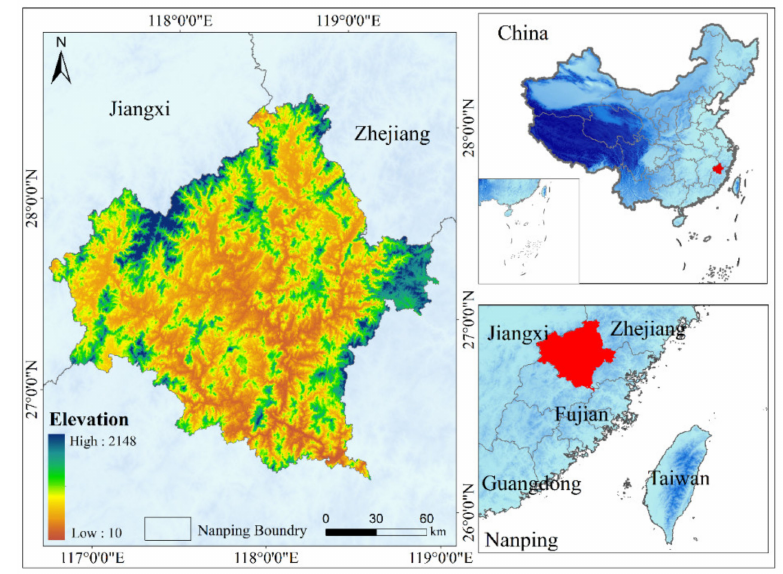
Figure 1. Location and elevation of study